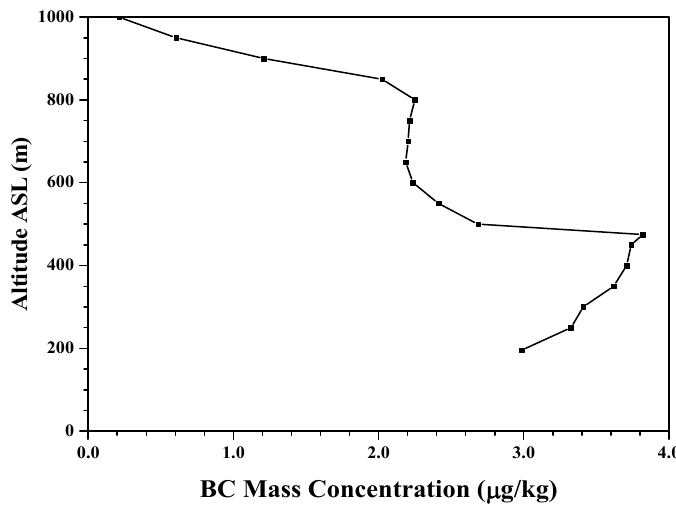
Figure 8. Simulated BC concentration at points along the flight path at 13:00 on 25 October.